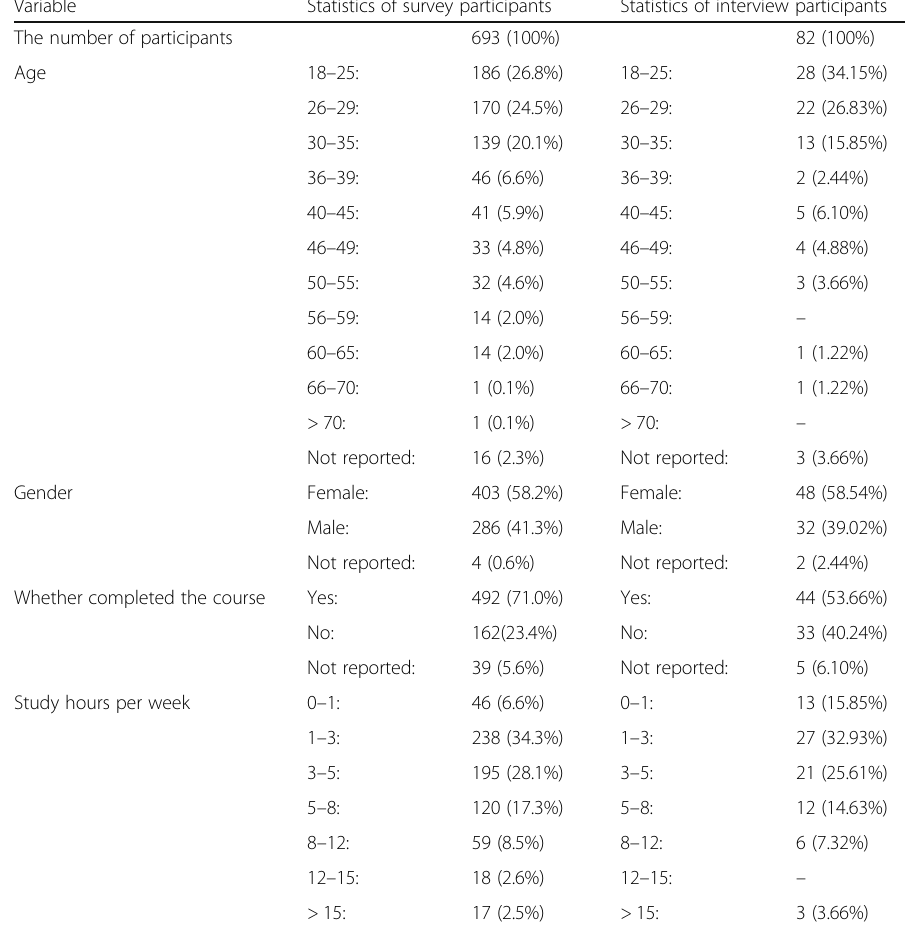
Table 1 Background information of participants Variable Statistics of survey participants Statistics of interview participants The number of